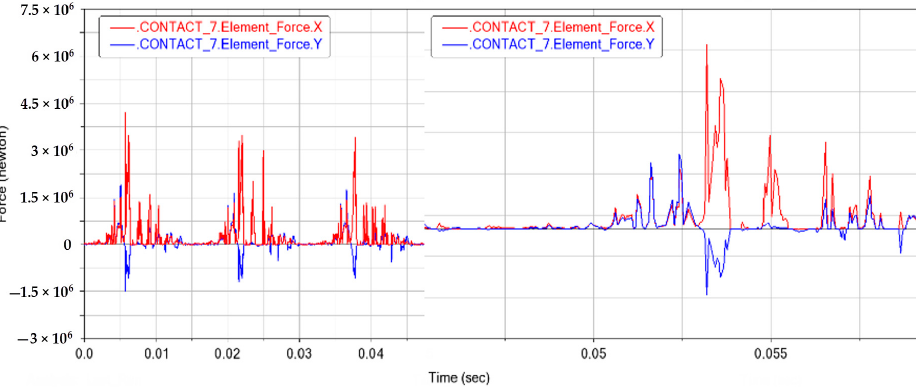
Figure 19. First crank pin tangential (Y)/diameter (X) direction force curve.